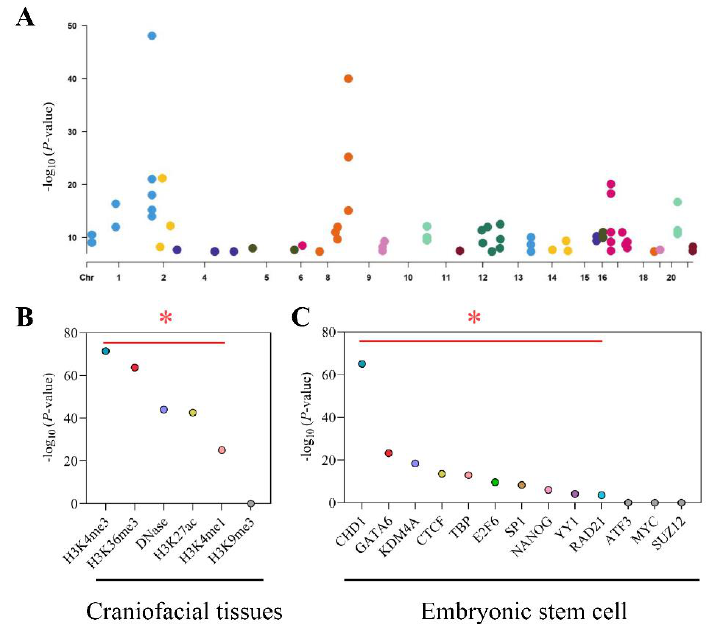
Figure 2. Identification and functional annotation of risk-eSNPs. ( A ) Significant NSCL/P risk SNPs across the genome. The x-axis shows the chromosome number, and the y-axis shows the -log 10 ( p ) value. ( B , C ) The -log 10 ( p ) value of eSNPs enrichment in histone marks and transcription factors, respectively. Marks with a significance level of p -value < 0.01 are highlighted above the red dotted line. * p < 0.01.